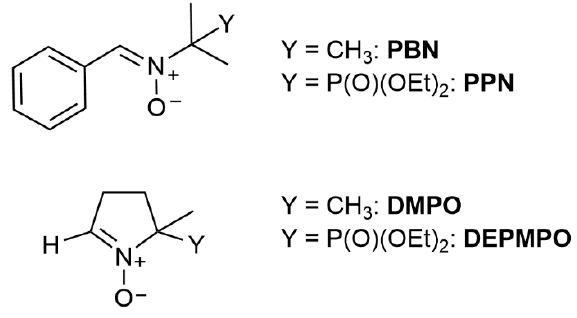
Figure 6. Selected nitrone spin traps.